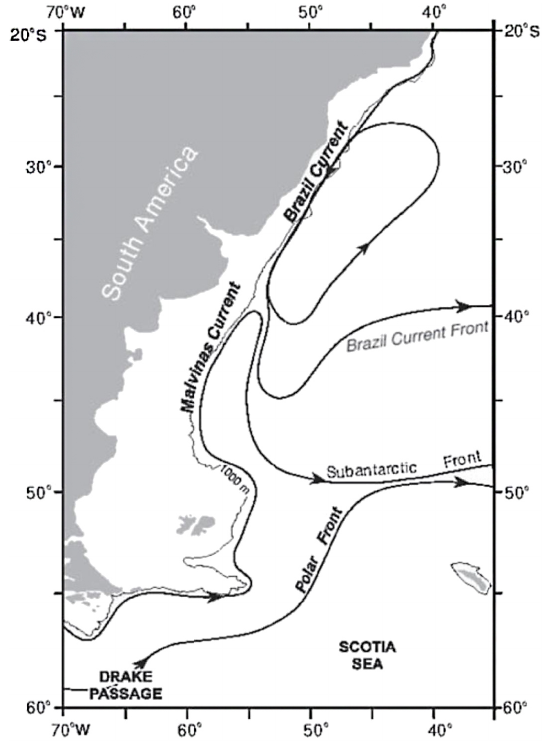
Fig. 1. Sketch of the upper-layer circulation in the southwestern Atlantic (from Saraceno et al.,